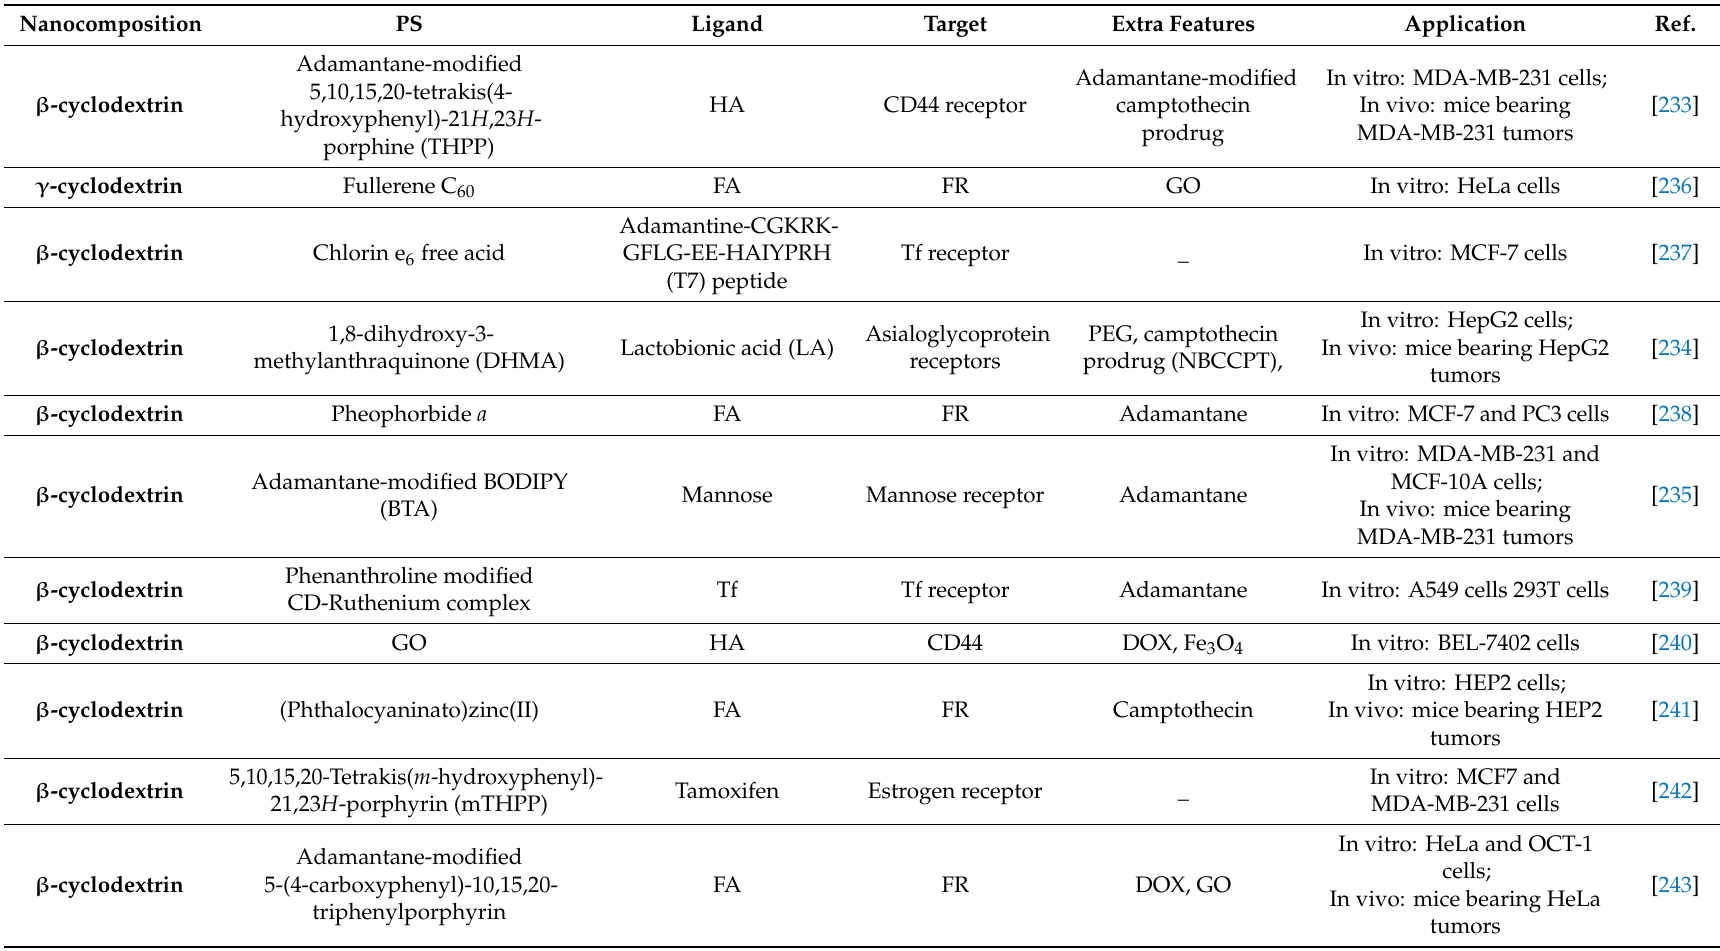
Table 6. Examples of ligand-targeted cyclodextrin-based NPs for